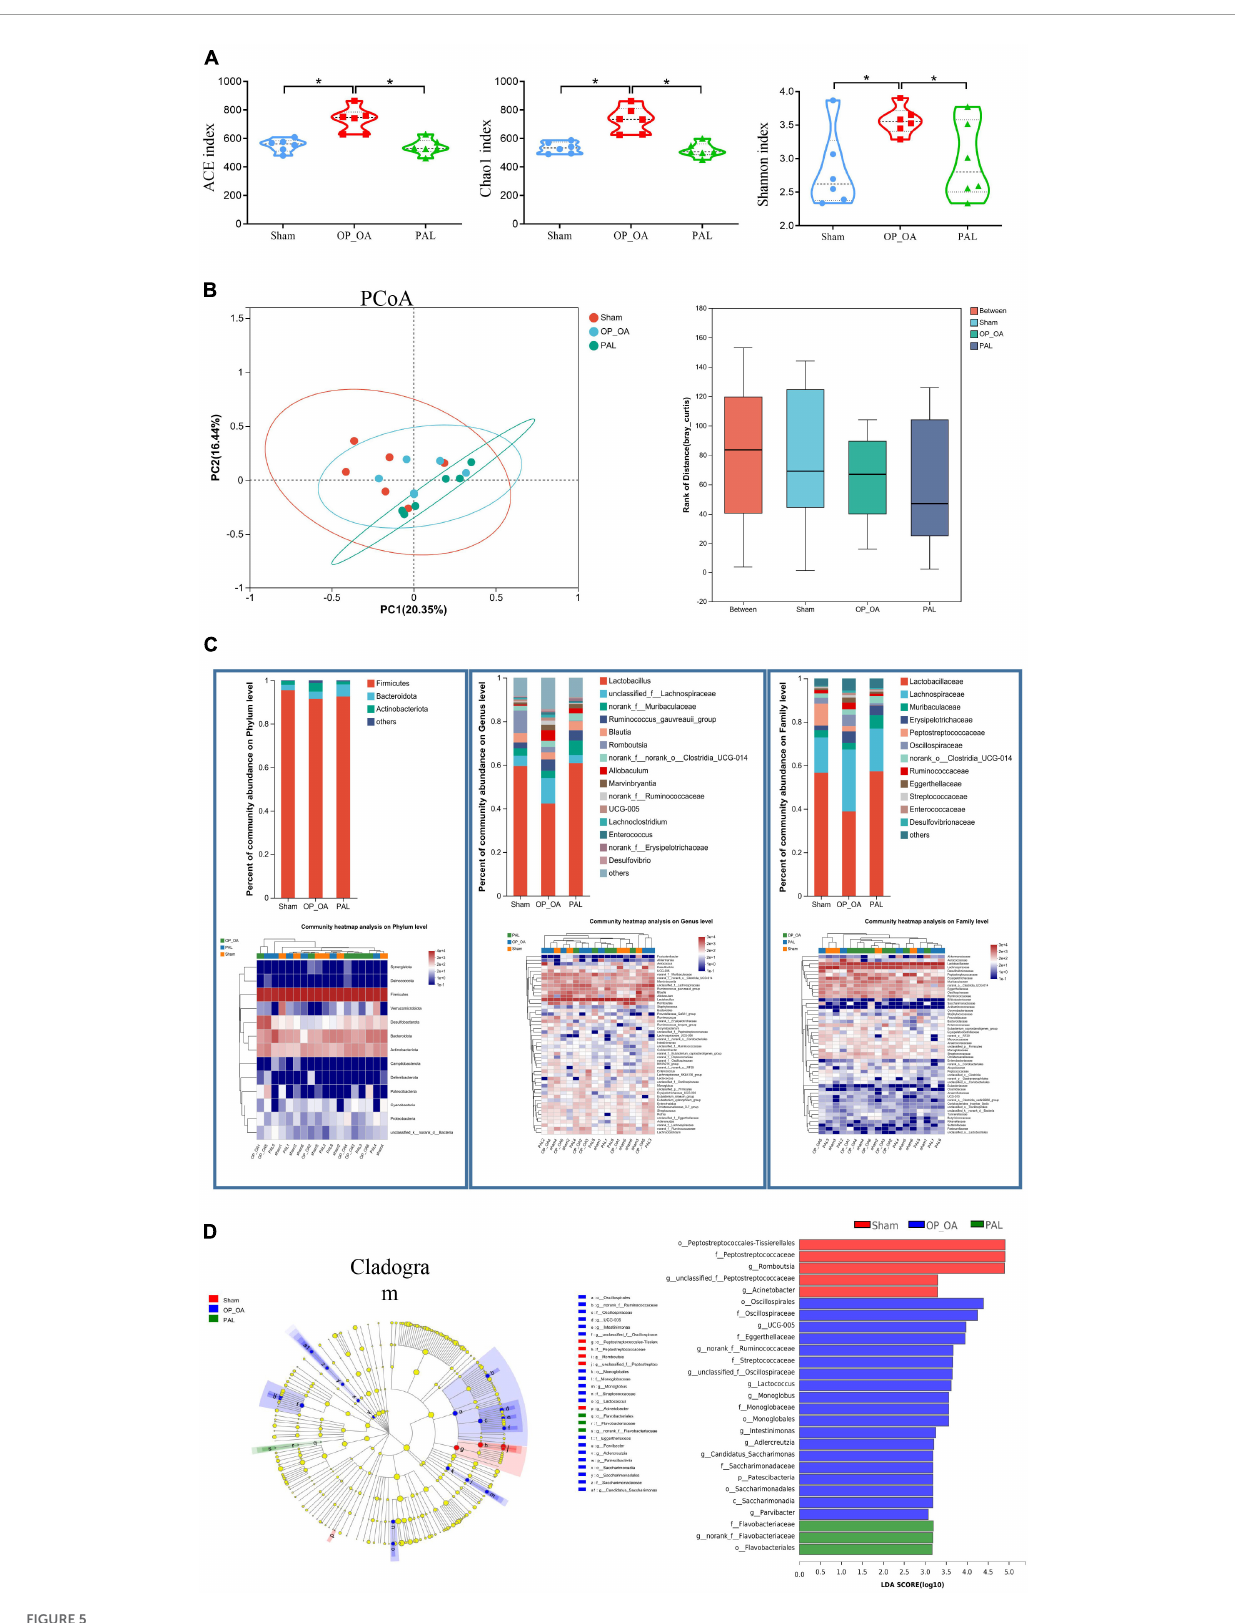
FIGURE5 Intestinal flora analysis. (A) The alpha diversity of intestinal microorganisms was evaluated through Chao1, ACE, and Shannon; (B) pCoA scoring chart and box diagram of distance between groups; (C) species composition abundance map and abundance clustering heatmap of phylum, genus and family level; (D) intestinal microbial LEfSe from domain to species and LDA showed scores of these specific bacteria. *Statistically significant difference ( P <